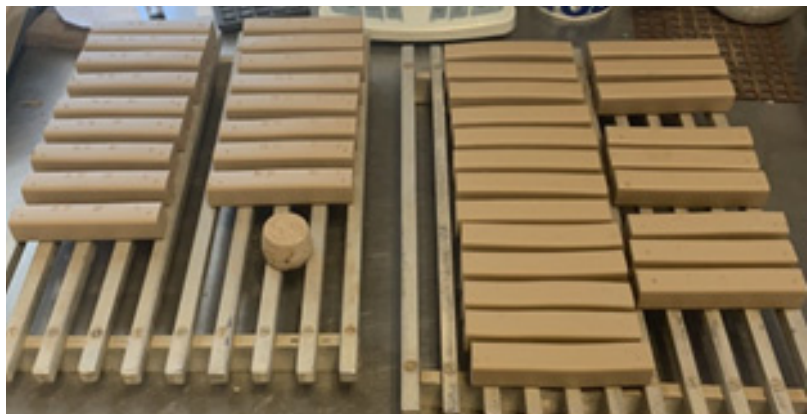
Figure 5. Dried samples before being placed to the electric laboratory kiln.